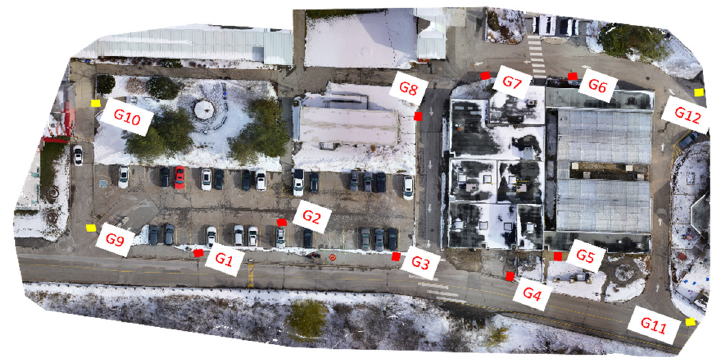
Figure 4. First study area with red and yellow squares highlighting the GCP positions. G1 through G12 represent the ground control points (GCPs) and check points.